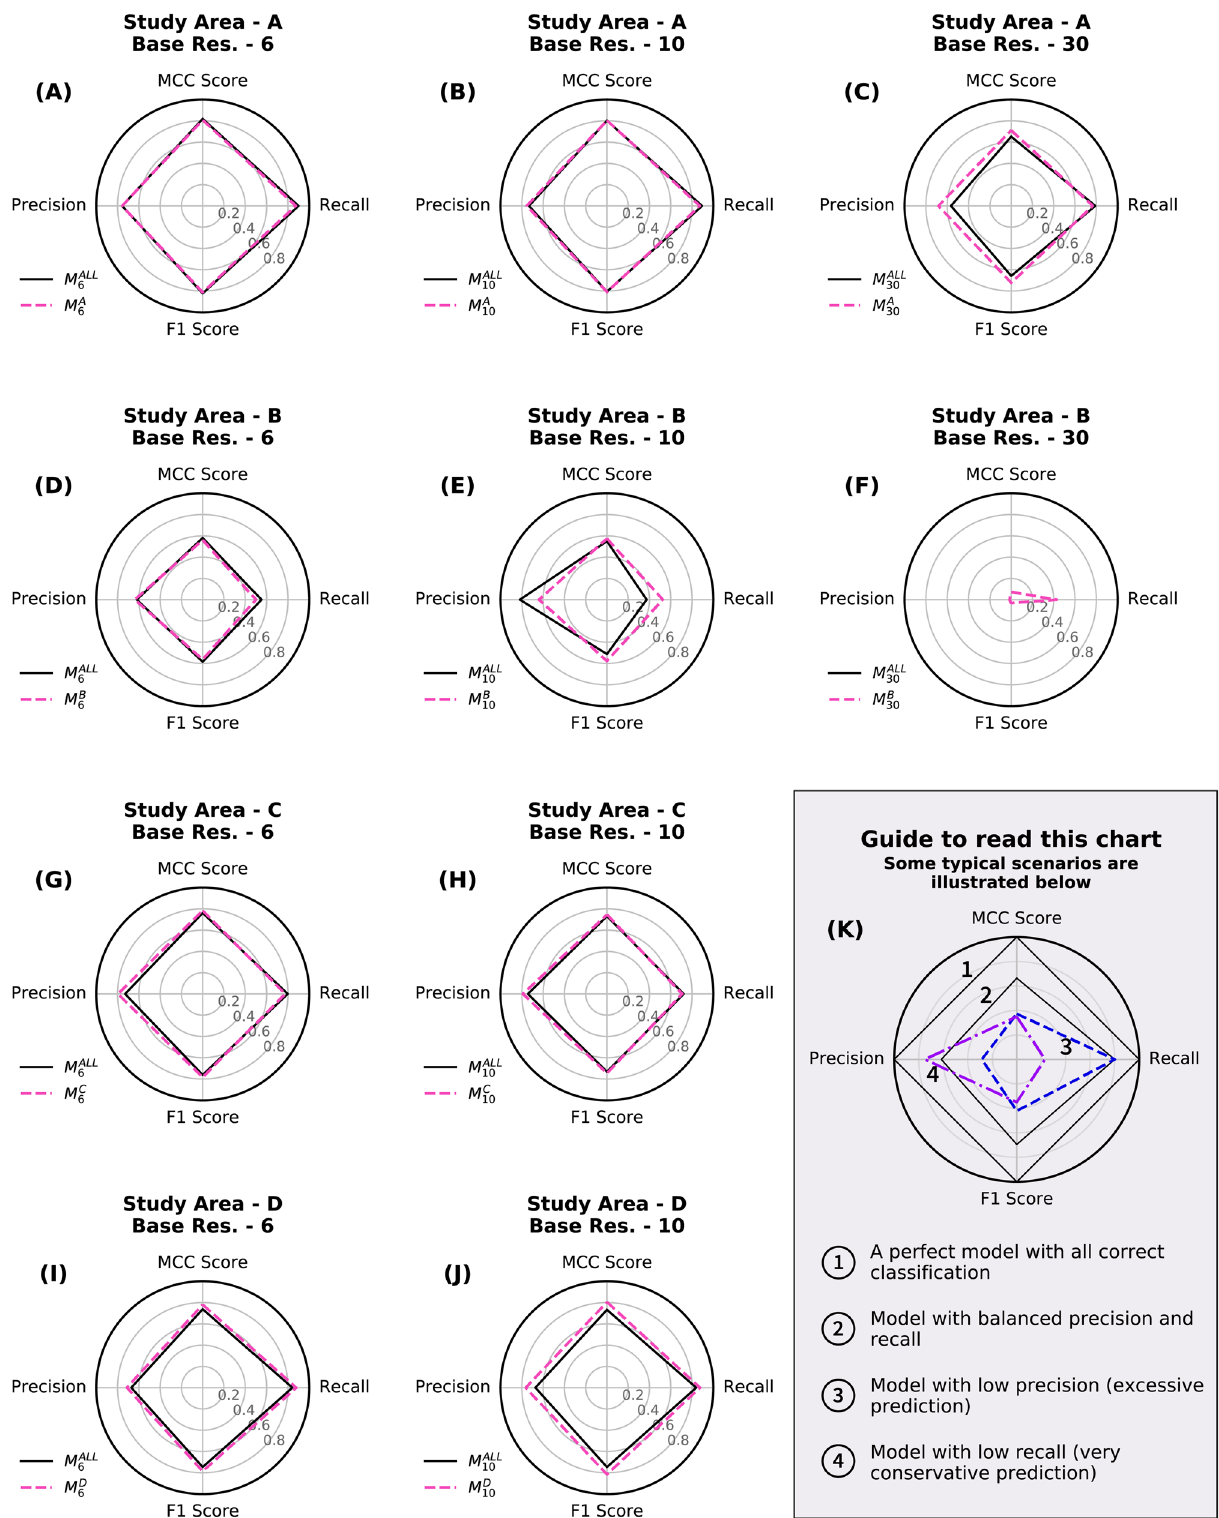
Figure 2. The spider plots ( A–J ) show the performance of CNNs trained with conventional learning (dashed line in pink) and combined learning (solid line in black) approaches. Every row has models evaluated for a specific study area at different base resolutions. The precision and recall scores are plotted on the X-axis, and the MCC and F1 scores are plotted on the Y-axis. ( K ) illustrates the shape expected from a good model which can be differentiated from models with lower precision or recall scores. The envelope of a better model will have a higher MCC/F1 Score and will enclose the plot from a weaker model. (Res. =